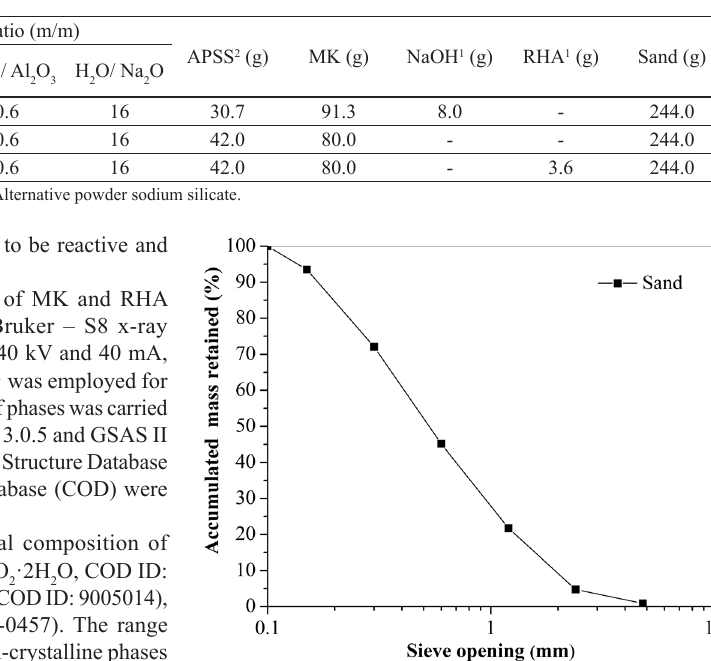
Figure 2. XRD patterns of MK (a) and RHA (b). Table 2. Mix design (in